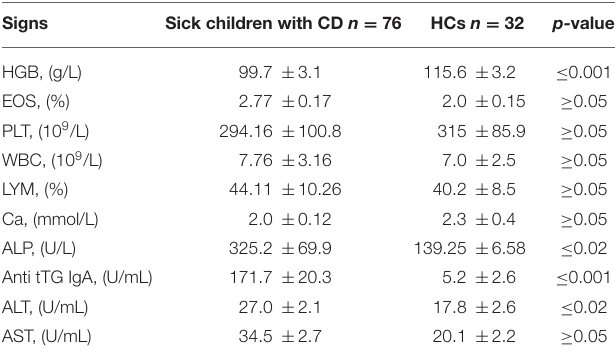
TABLE 3 | Antimicrobial peptide values in children with celiac disease.